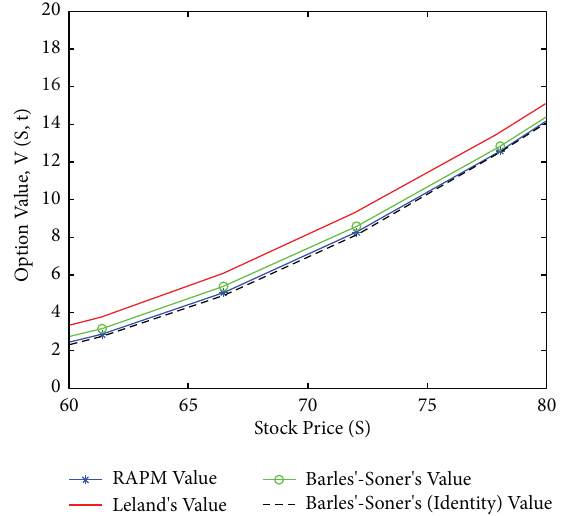
Figure 4: 2D plot of the volatility models by the differential quadrature method at t �